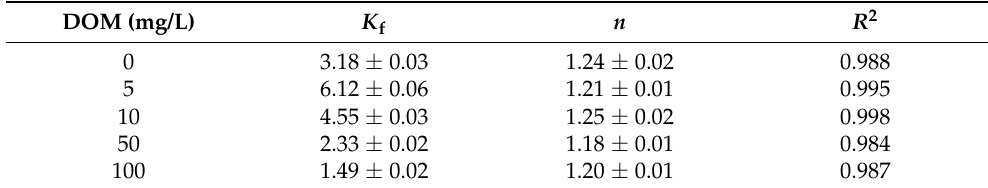
Table 5. Freundlich model parameters of 2,3,7,8-TCDT in in sediments of eastern Chaohu Lake at different DOM levels.